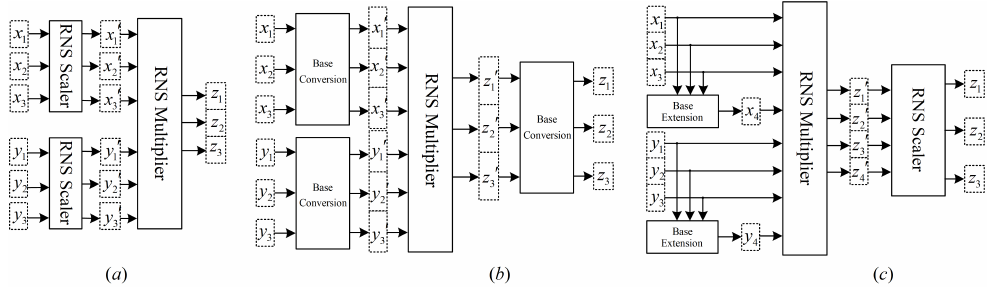
Figure 1. Three traditional overflow-free RNS multipliers. ( a ) Scaling-based scheme, ( b ) Base Conversion-based scheme, ( c ) Base Extension-based